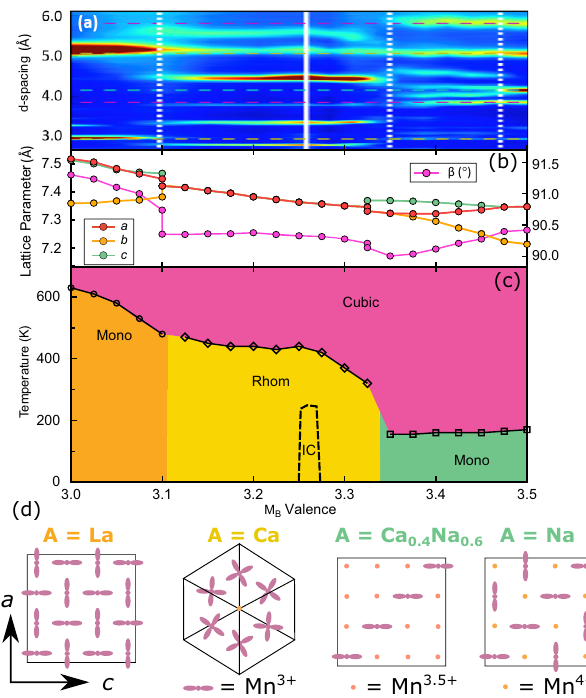
Fig. 2 The experimental phase diagram of the AMn 7 O 12 series, plotted as a function of formal B-site valence, constructed from 21 samples measured by synchrotron X-ray powder diffraction (SXRD) and neutron powder diffraction (NPD). a Four distinct regions of the phase diagram are evident from the low-temperature low- d -spacing NPD data, plotted as a heat map. b Lattice parameters at 80 K evidence 4 kinds of metric symmetry. c the temperature-doping phase diagram constructed from the variable temperature SXRD and NPD data. IC denotes an incommensurate phase that is found for limited stoichiometric variation around A = Ca. d The orbital-ordered structures in the four distinct regimes determined in the present